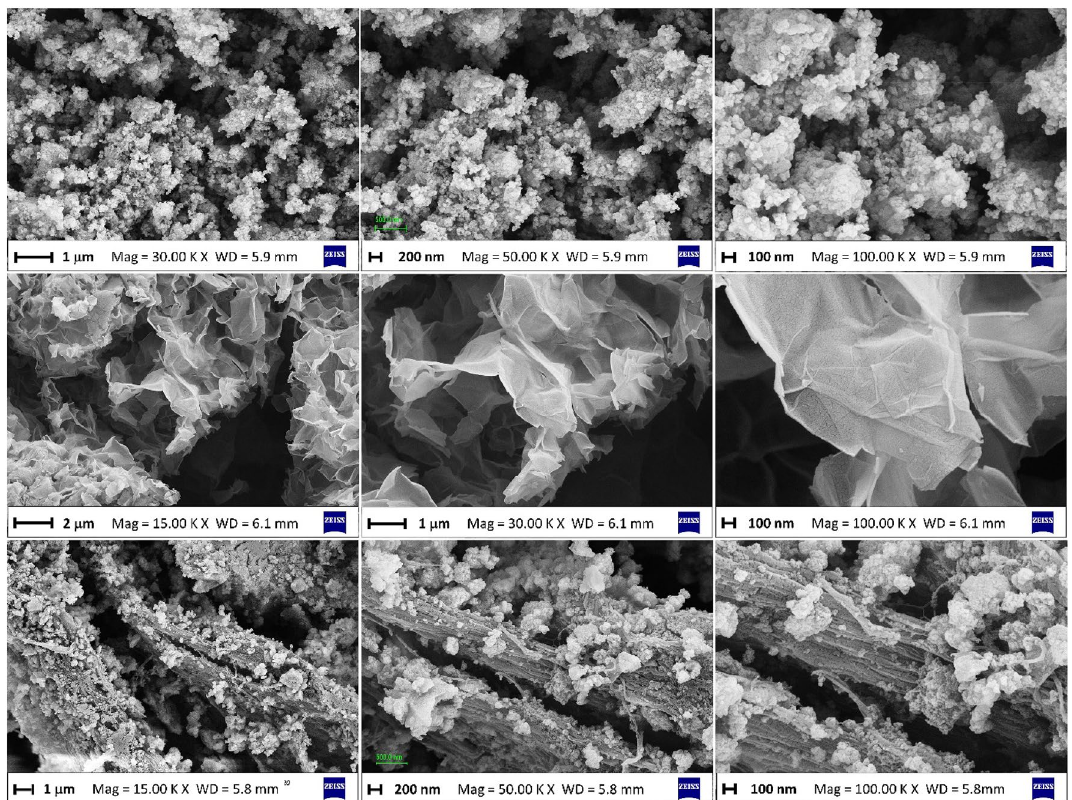
Figure 2. FESEM images of the pure UiO-66(Zr)-(COOH) 2 (first row), pure Ni 50 Co 50 -LDH (second row), and LDH/MOF NC (third